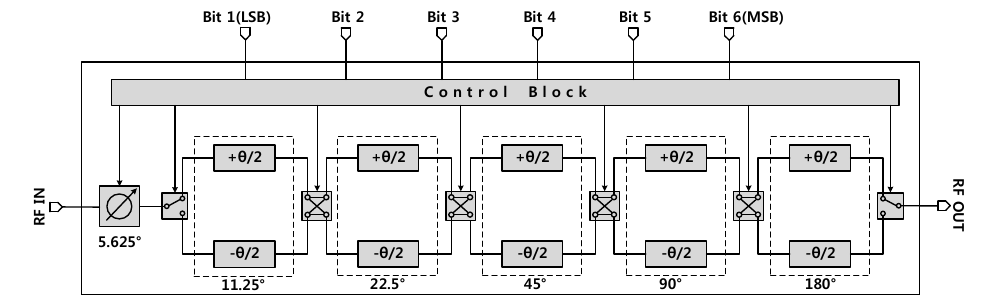
Figure 2. A block diagram of the proposed 6-bit phase shifter.